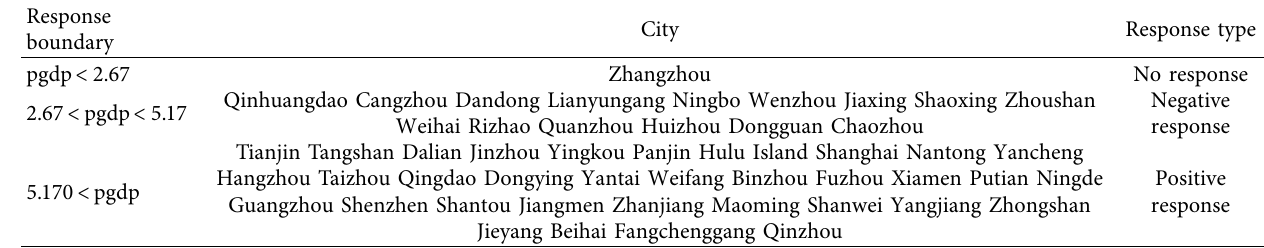
Table 4: Identification of city type by the first threshold regression results.